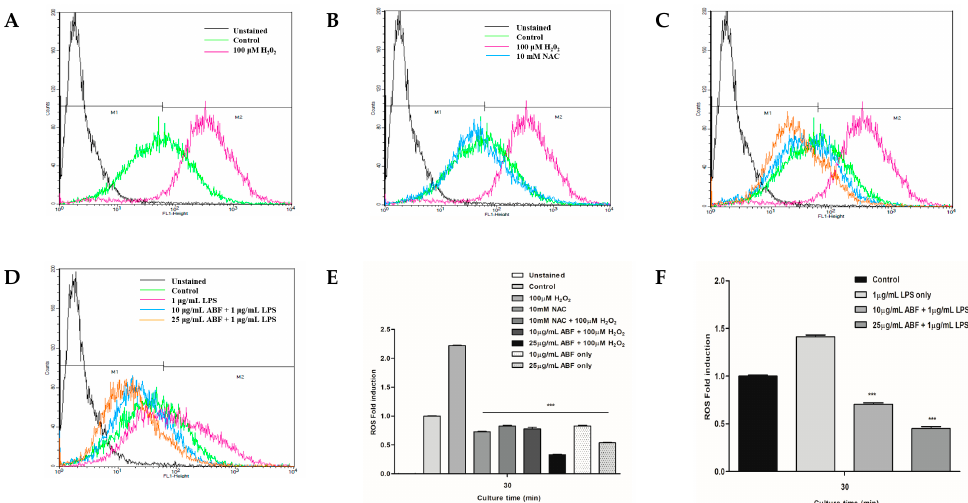
Figure 5. E ff ects of aronia bioactive fraction (ABF ® ) on lipopolysaccharide (LPS)-induced reactive oxygen species (ROS) generation in BEAS-2B Cells. Cells were pretreated with ABF ® (10 and 25 µ g / mL) for 4 h before treatment with LPS (1 µ g / mL) for 6 h. ABF ® attenuated LPS-induced ROS production in BEAS-2B cells. The values are presented as means ± standard deviation (SD) of three independent experiments. *** p < 0.01 indicate significant di ff erences as compared to the LPS-treated cells. ( A ) control and 100 µ M H2O2 treated cells; ( B ) Control, 100 µ M H2O2 and 10 mM NAC treated cells; ( C ) Control, 10 µ g / mL ABF and 25 µ g / mL ABF treated cells; ( D ) Control, 10 µ g / mL ABF + 1 µ g / mL LPS and 25 µ g / mL ABF + 1 µ g / mL LPS treated cells; ( E ) ROS induction; ( F ) ROS induction and ABF’s e ff ects under LPS